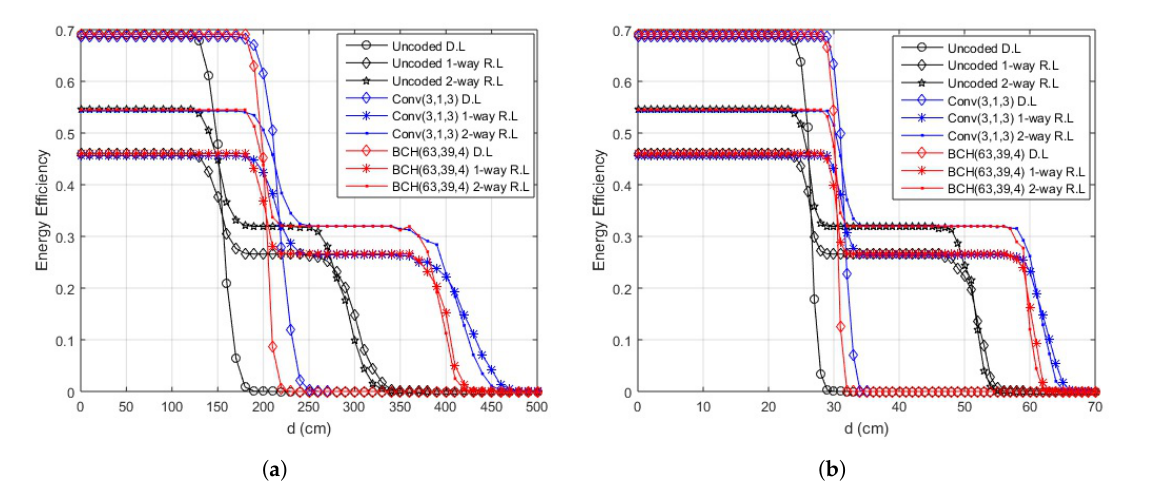
Figure 17. Energy efficiency for JNC coded data, convolutional R = 1/3, BCH t = 4 (on-body communication). ( a ) energy efficiency for JNC coded data, convolutional R = 1/3, BCH t = 4 (on-body LOS communication); ( b ) energy efficiency for JNC coded data, convolutional R = 1/3, BCH t = 4 (on-body NLOS